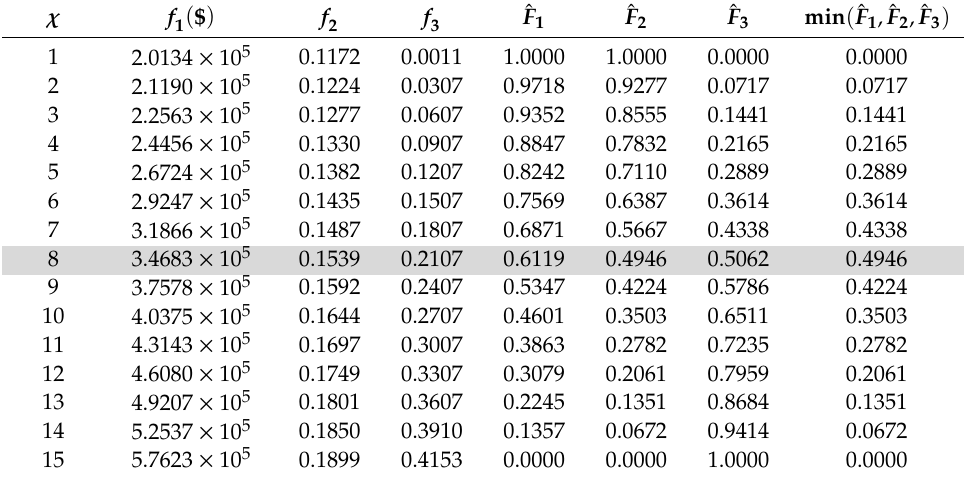
Table 16. Obtained Pareto optimal solutions for the probabilistic multi-objective RPP considering load demand and wind power generation